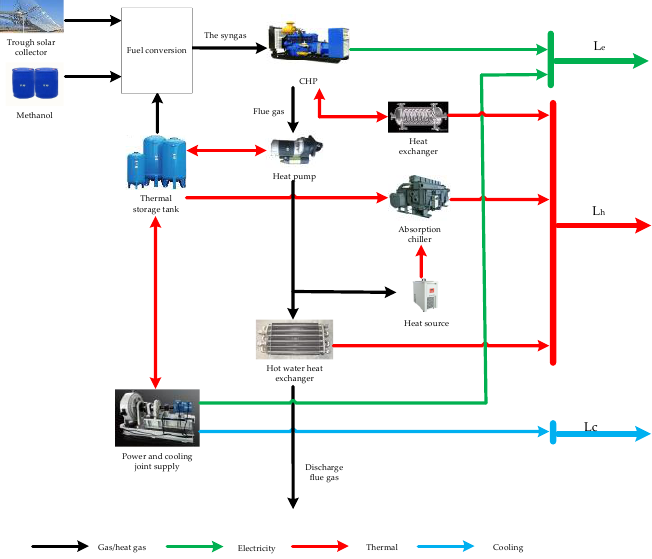
Figure 2. Energy flow chart of cooling-thermal-electric coupling link.